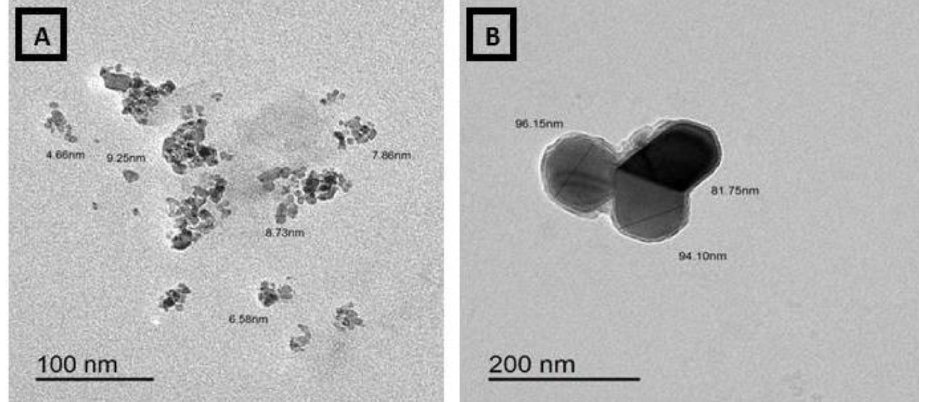
Figure 8. TEM of MoO 3 -NPs ( A , B